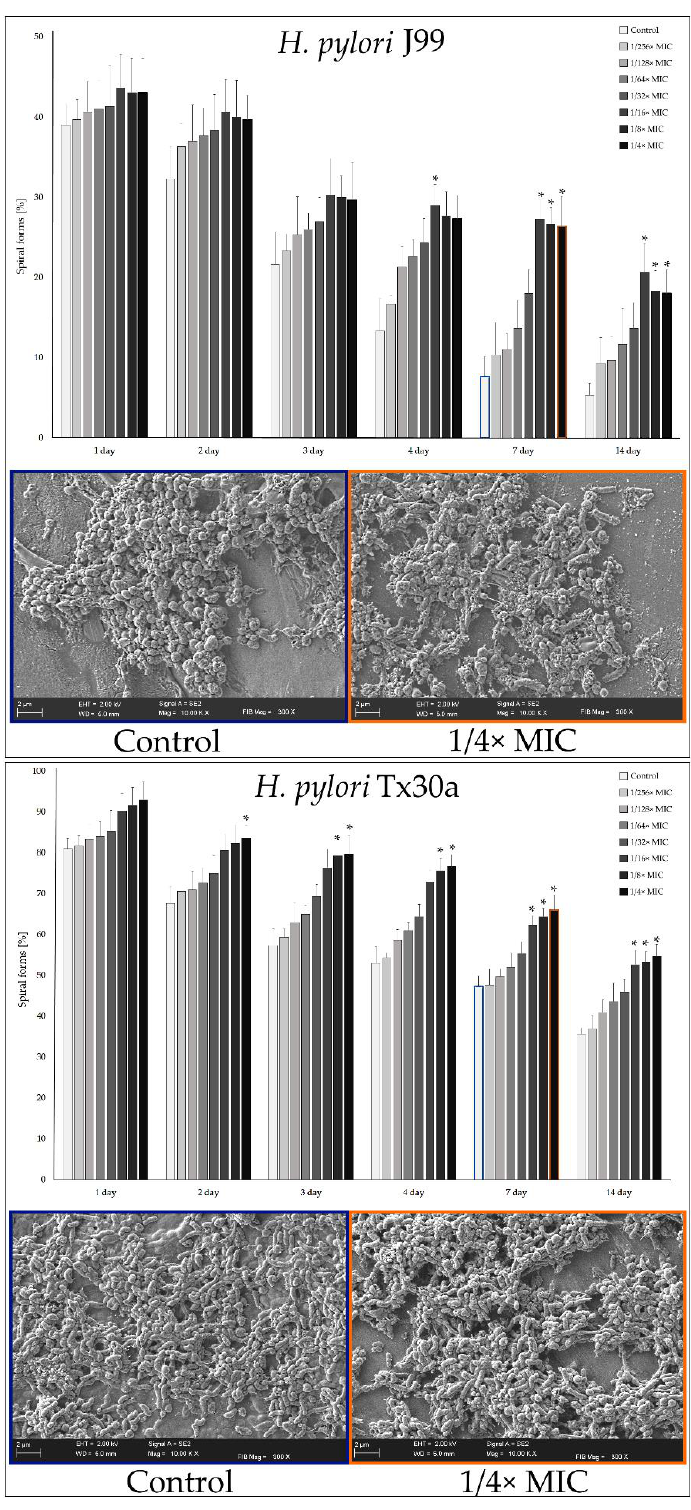
Figure 3. The concentration- and time-dependent activity of myricetin in inhibiting the transition of reference H. pylori J99 and Tx30 strains from spiral to coccoid forms during serum starving conditions. The MIC of myricetin for both strains is equal to 160 µg/mL. The initial number of spiral forms (a 0-h time point) was 90% and 98% for H. pylori J99 and Tx30a, respectively. Results are presented as means ± standard deviations from three independent biological experiments. * Indicates statistically significant difference ( p ≤ 0.05).